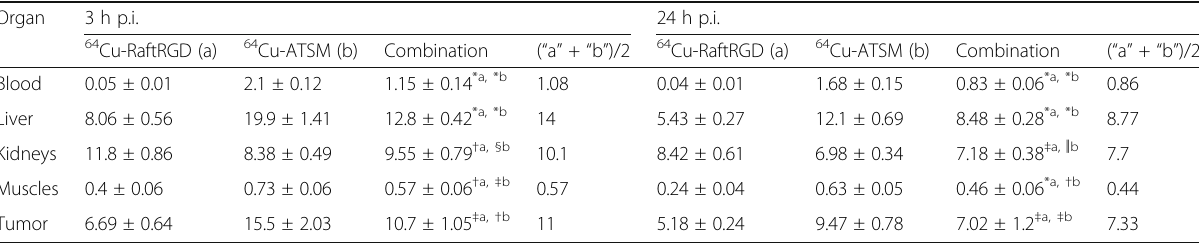
Table 1 Biodistribution of 64 Cu-RaftRGD, 64 Cu-ATSM, and a combination of both in U87MG tumor-bearing mice